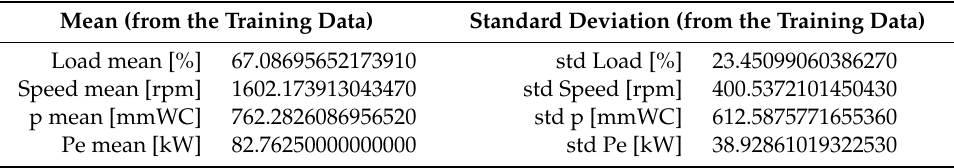
Table A3. The normalization reference